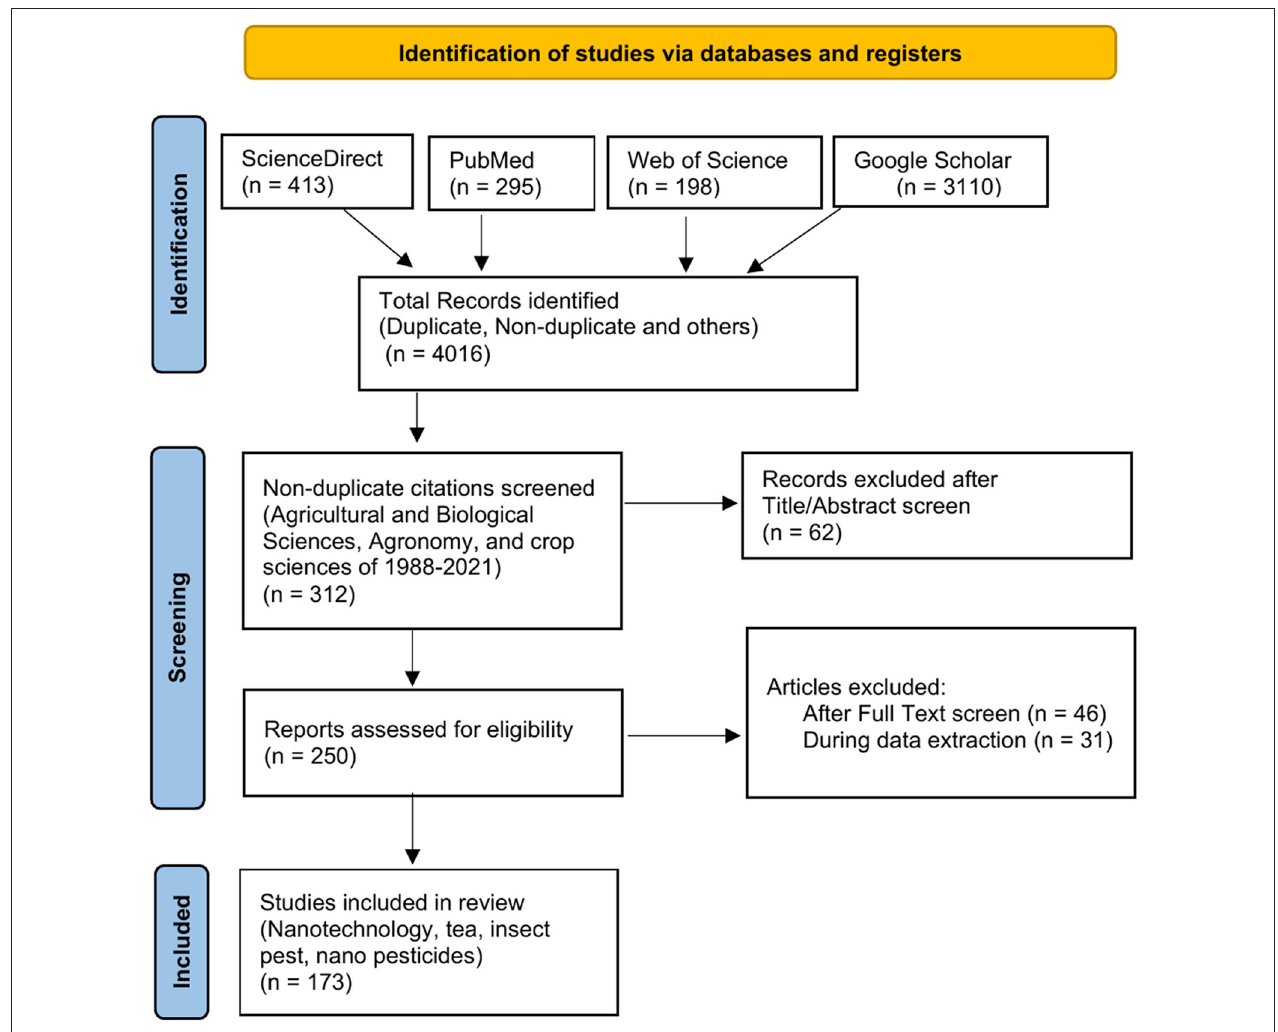
FIGURE 2 | The flowchart of the literature search, screening and